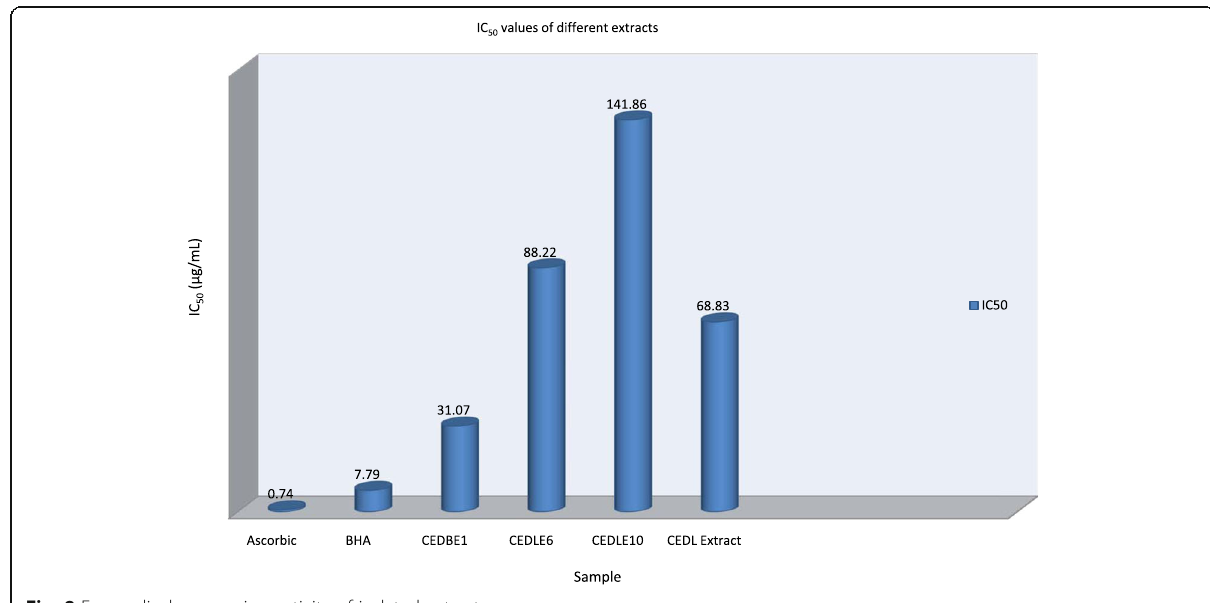
Fig. 8 Free radical scavenging activity of isolated extracts